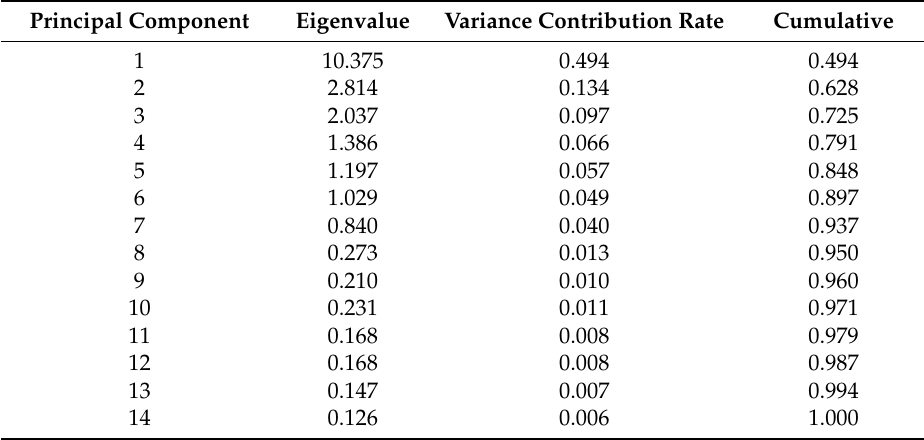
Table 2. Eigenvalues and contribution